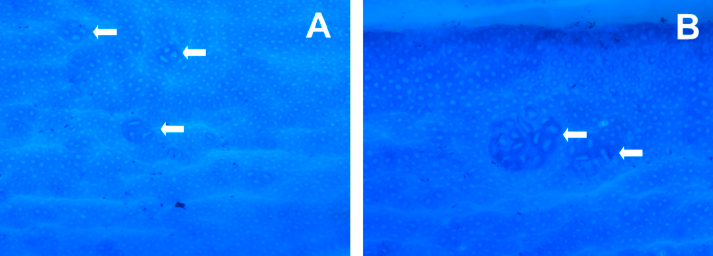
Figure 2. Appearance of small and large aberrant crypt foci (ACF) in rat colon tissue. ( A ) Small ACF (enlarged) < 7, where white arrows show crypts of 3 and 4. ( B ) Large ACF (enlarged) > 7, where white arrows show crypts > 7. The epithelial lining was visualized by Giemsa stain (×200).